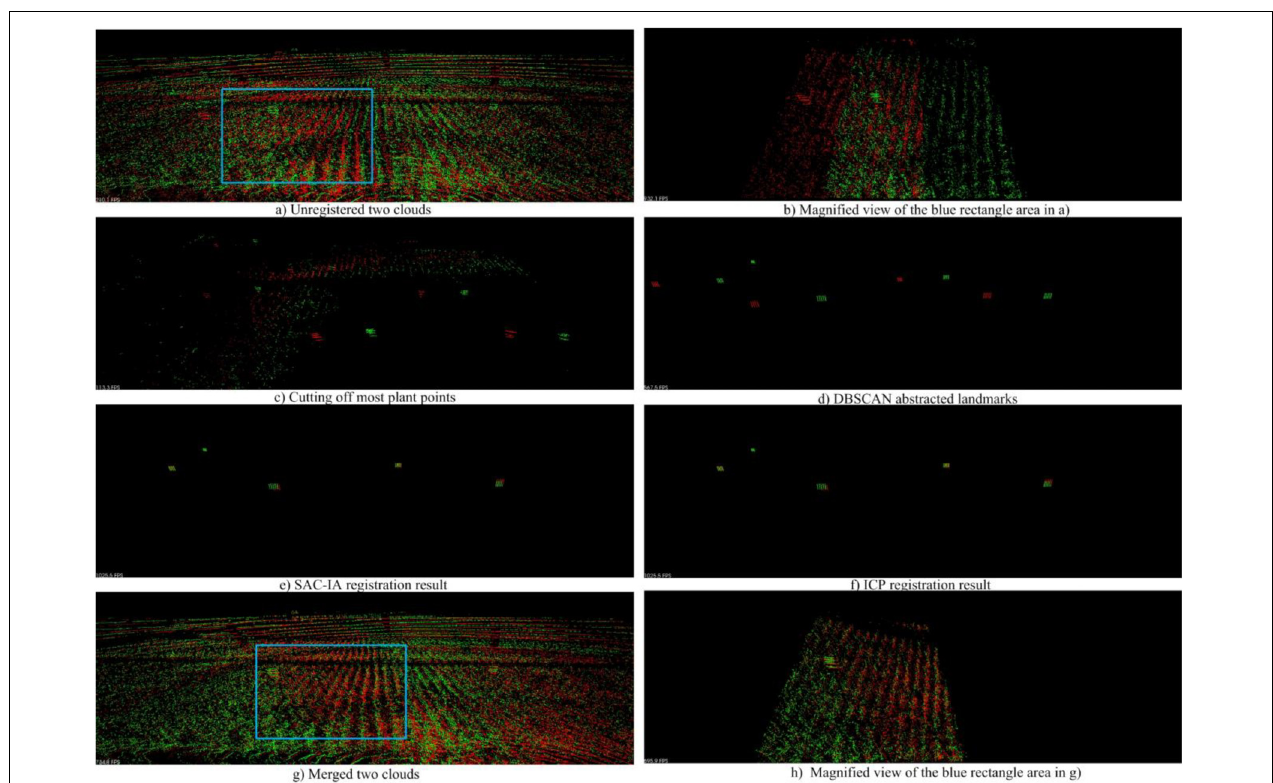
FIGURE 16 | Cloud registration and merging process. (A) Shows the unregistered two point clouds; (C) shows the landmark points and noise points after cutting off most plant points; (D) shows the virtual landmarks generated after DBSCAN; (E) shows the SAC-IA registration result; (F) shows the IPC registration result; (G) shows the merged two clouds; (B) and (H) show the magnified views of the blue rectangle areas in (A) and (G) ,